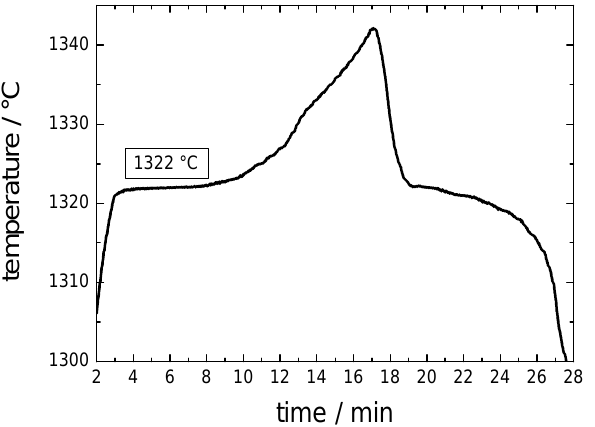
Fixed point ref. temperature Characteristics after 2-point calibration: